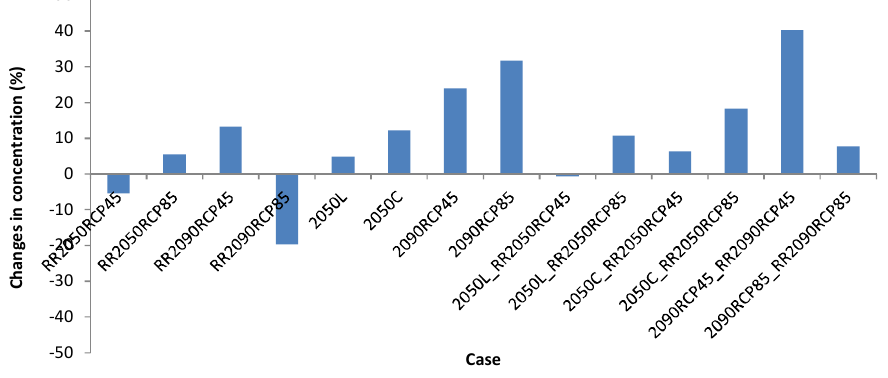
Figure 5. Salinity changes (%) relative to the baseline at the observation node for the 14 scenarios.